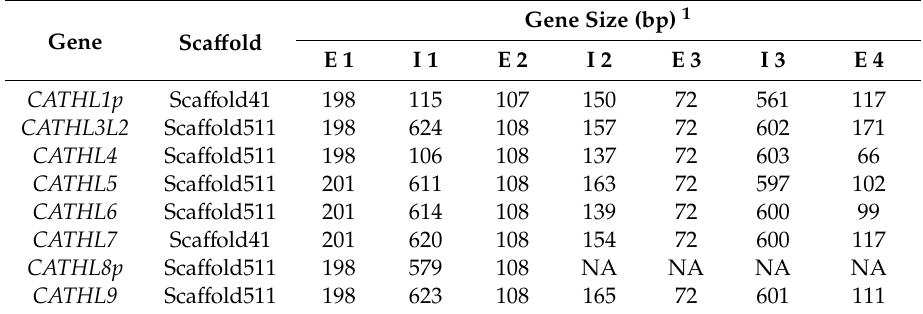
Table 2. Gene and genomic organizations of forest musk deer